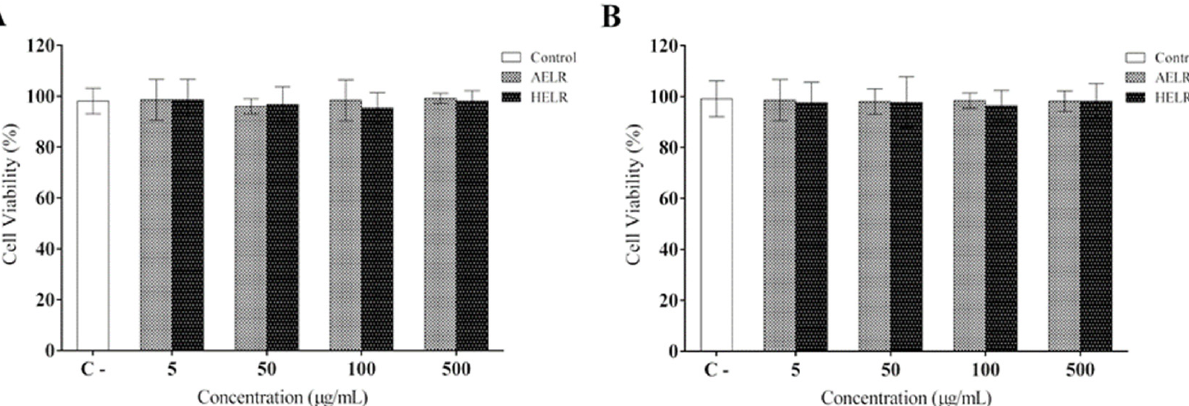
Figure 3. Total leukocyte count in ( A ) LPS-induced peritonitis model and ( B ) differential leukocyte count in an LPS-induced peritonitis model. L. rigida aqueous leaf extract (AELR); L. rigida hydroethanolic leaf extract (HELR), − C (negative control: animals not induced with LPS) and + C